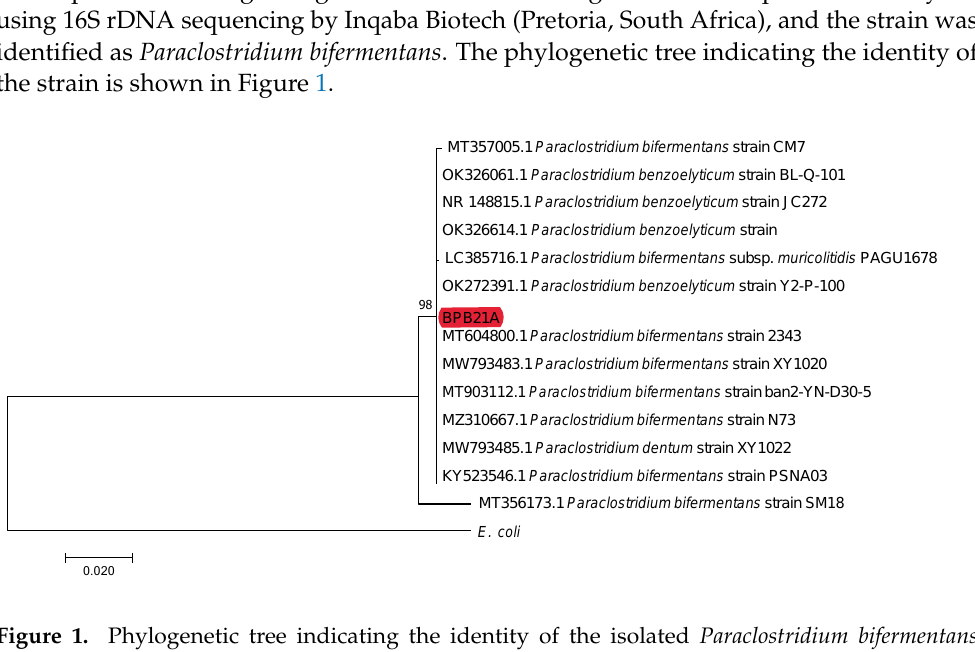
Figure 1. Phylogenetic tree indicating the identity of the isolated Paraclostridium bifermentans strain